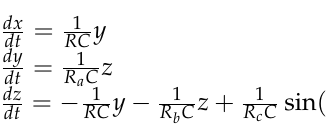
Figure 13. Realization circuit of the sinusoidal function.